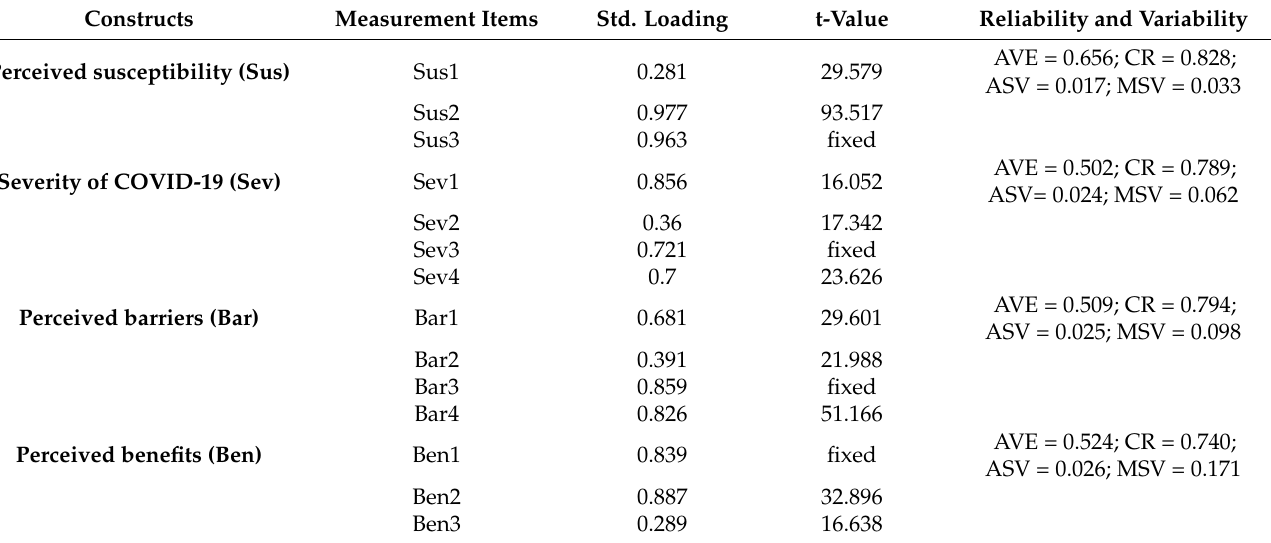
Table 4. Results of first-order confirmatory factor